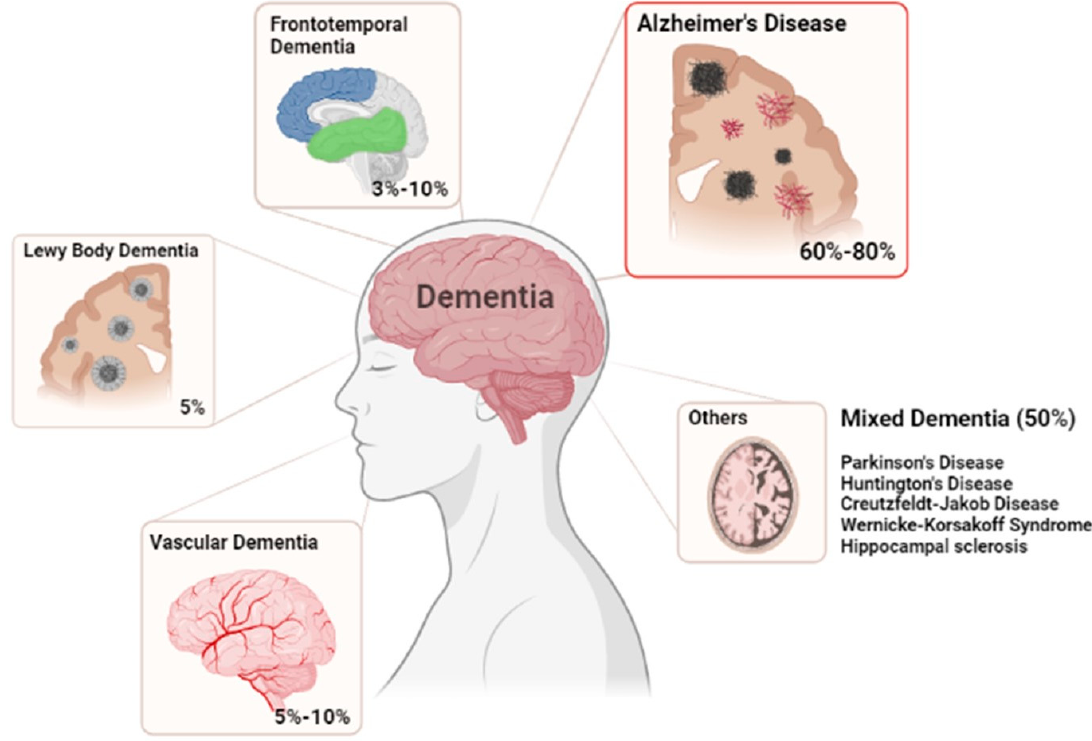
Figure 1. Most common forms of Dementia. Illustrating the correspondent percentages of cases for each disease.